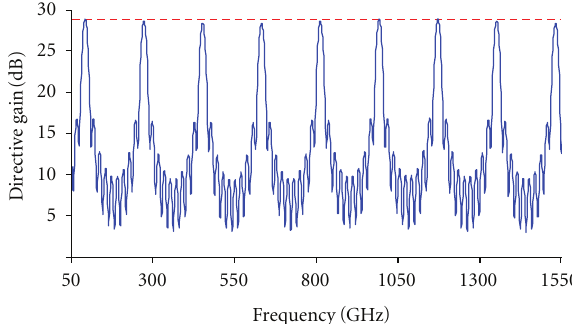
Figure 5: Frequency-domain harmonic action of binary FZP antenna: directive gain versus frequency. Table 2: Frequency-domain radiation parameters of FZP lens antennas: microwave (M) and terahertz (T) designs. FZP antenna F/D = 0 .